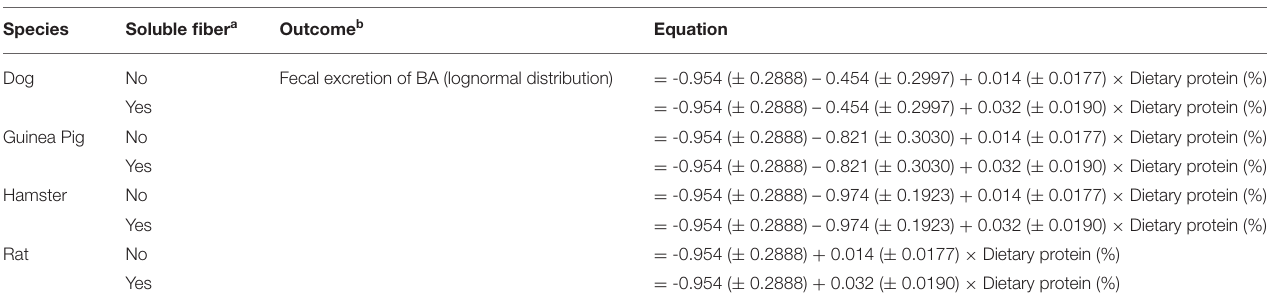
TABLE 7 | Protein model equations for total fecal bile acids